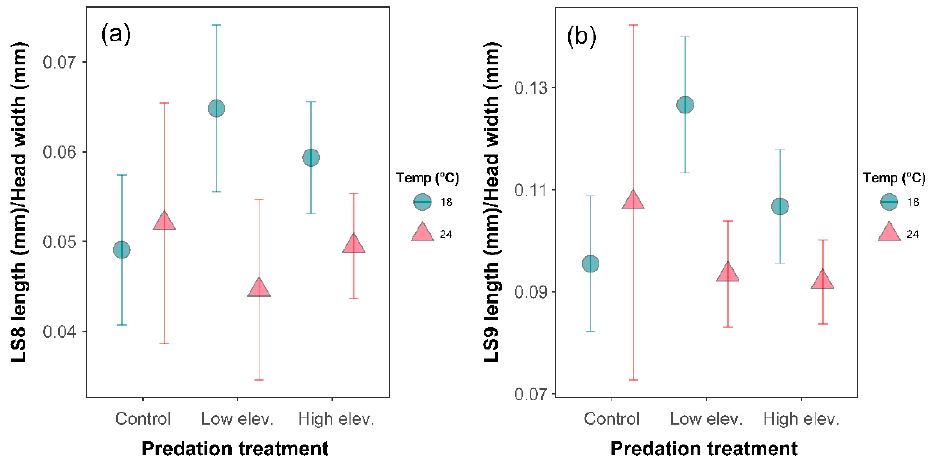
Figure 5. Length of the 8th ( a ) and 9th ( b ) lateral spine of Sympetrum striolatum larvae in the combination of two temperature and three predator treatments. Error bars are 95% confidence intervals.